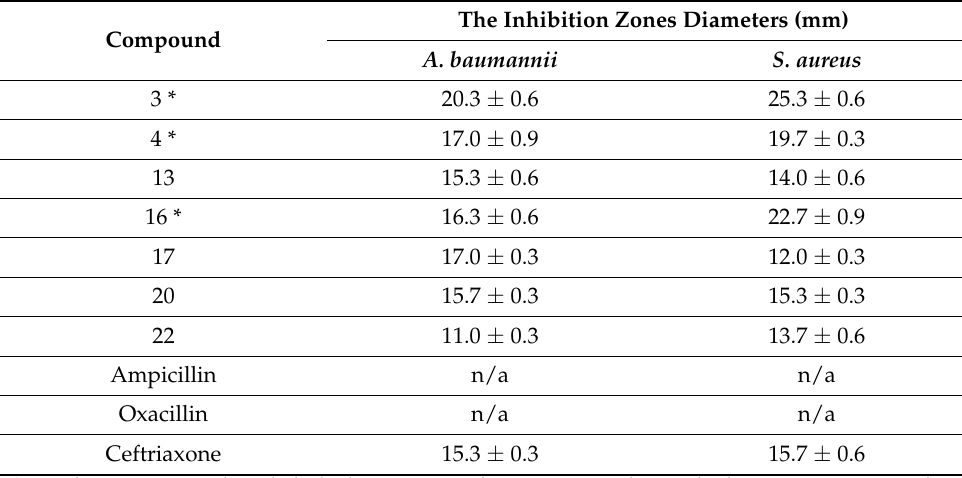
Table 3. Antibacterial activities of studied ILs with predicted